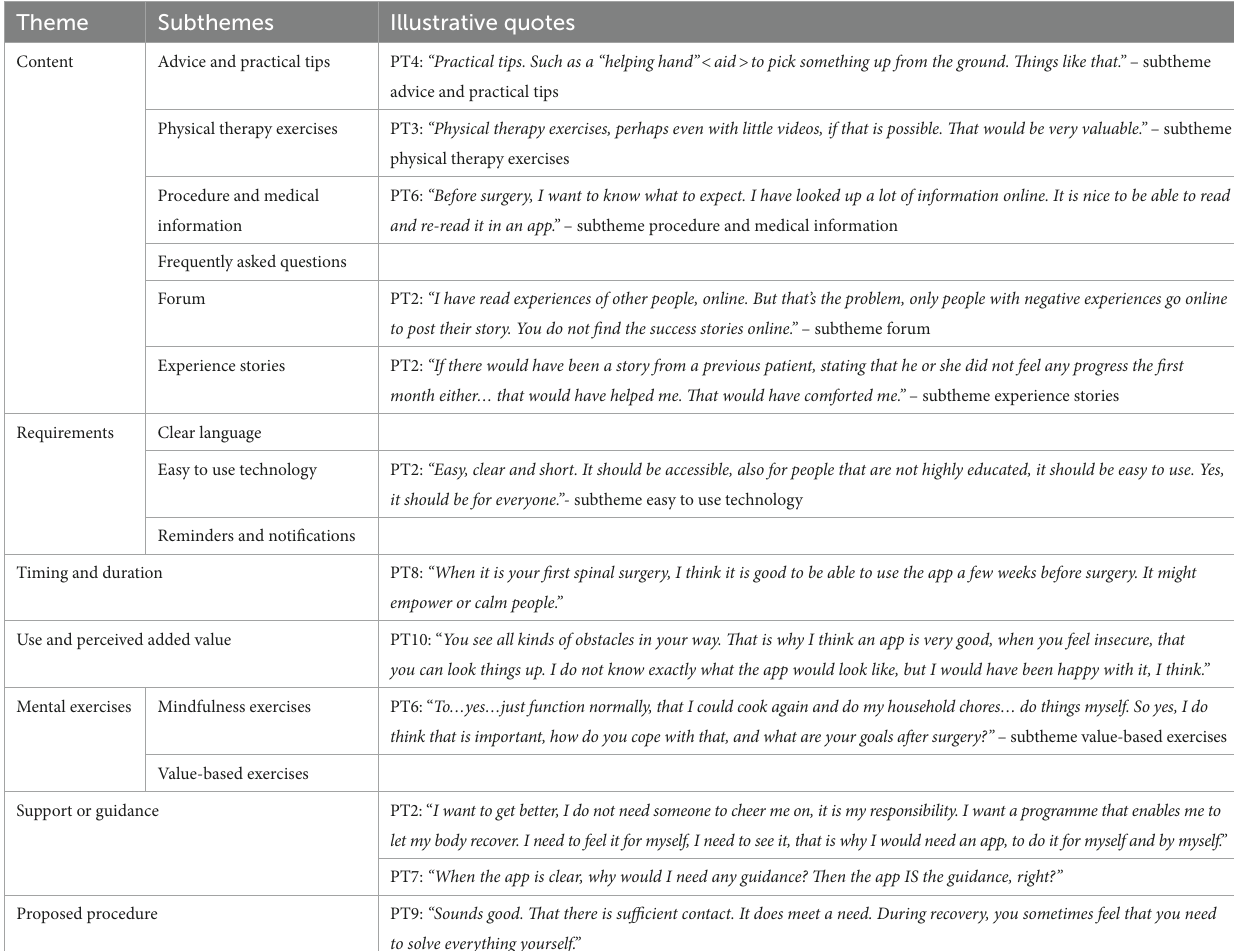
TABLE 1 Thematic analysis – patient interviews – themes and illustrative